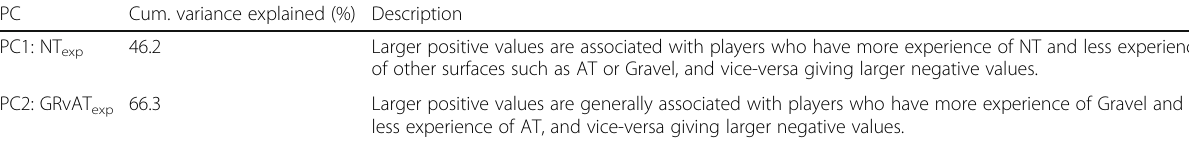
Table 1 Interpretations of the first two principal components and cumulative variance explained